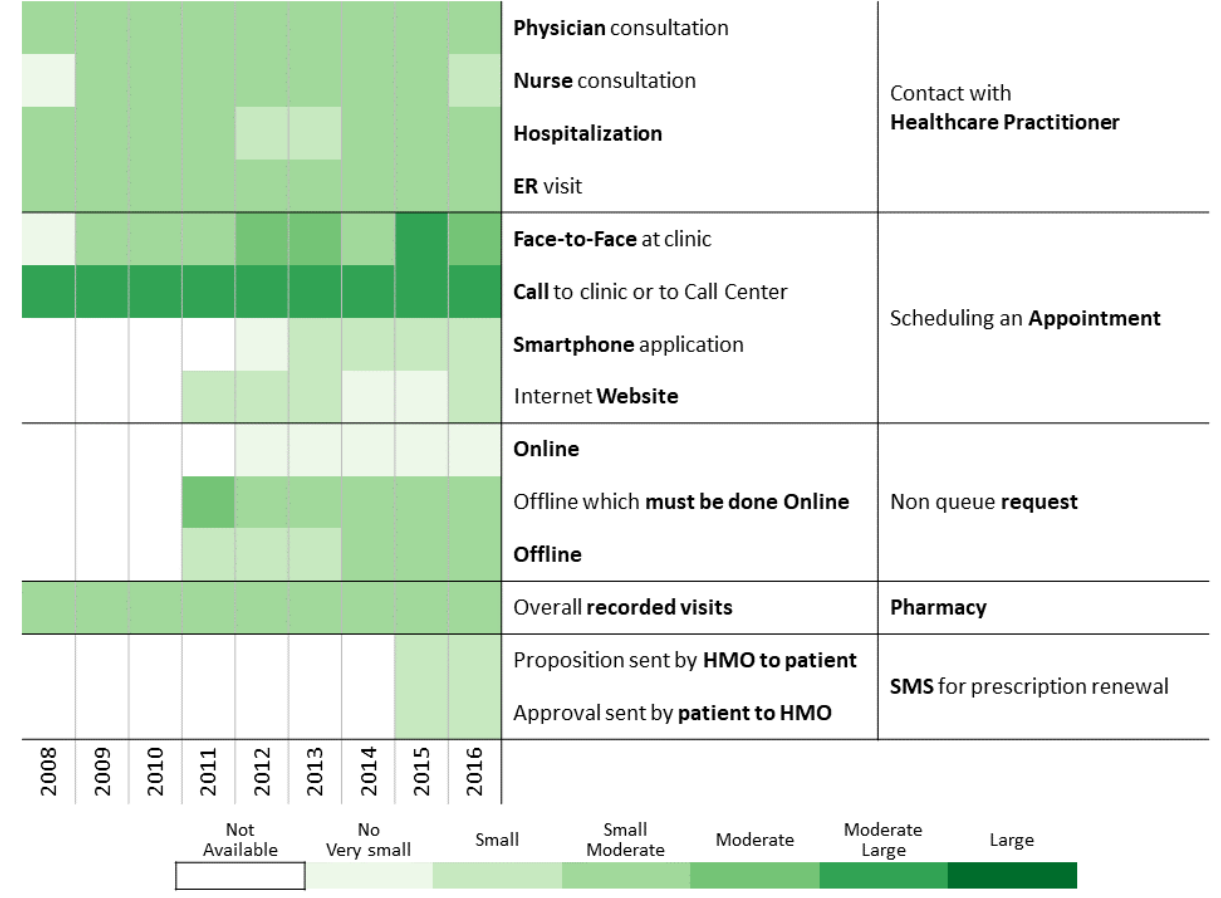
Figure 10. Communication patterns for patients with diabetes having low balance use of health care services and scheduled